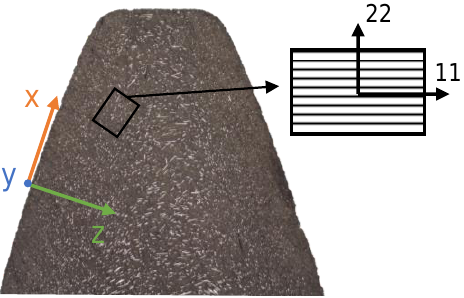
Figure 1. Cross-sectional microscopy of the short glass fibers orientation in an injection molded gear tooth (m n = 3 mm) with schematic coordinate systems.